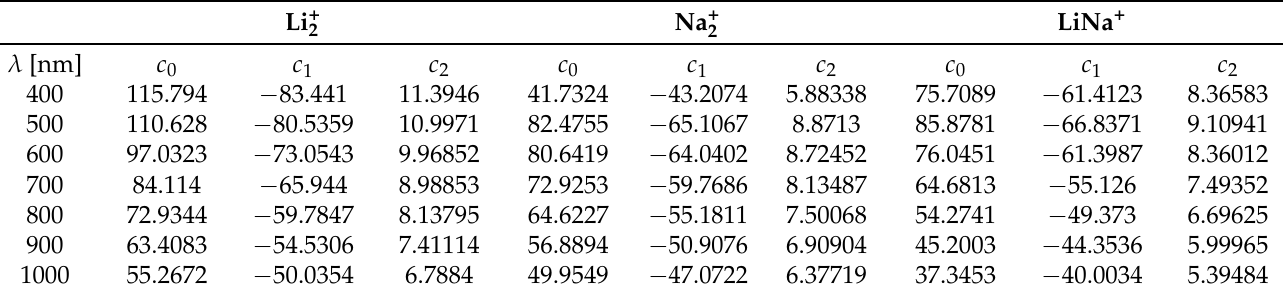
, Na + and LiNa + . 2 2 LiNa +